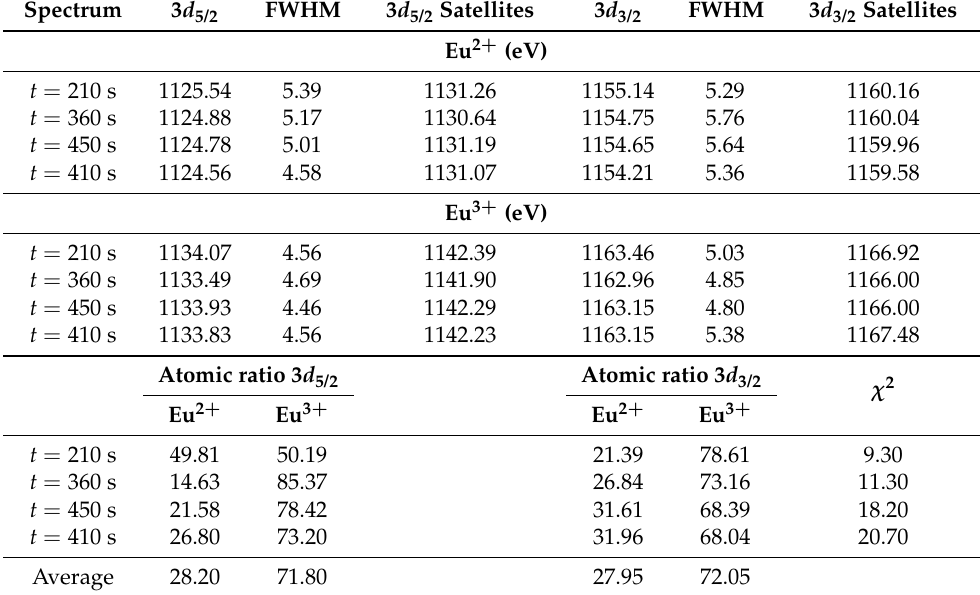
Table 1. The positions of the Eu 2 + and Eu 3 + 3 d peaks, their FWHM and the position of their corresponding multiplet satellites. The atomic ratios of the Eu 2 + to Eu 3 + were deduced from the areas of the peaks. The table also lists the χ 2 value of the fittings.